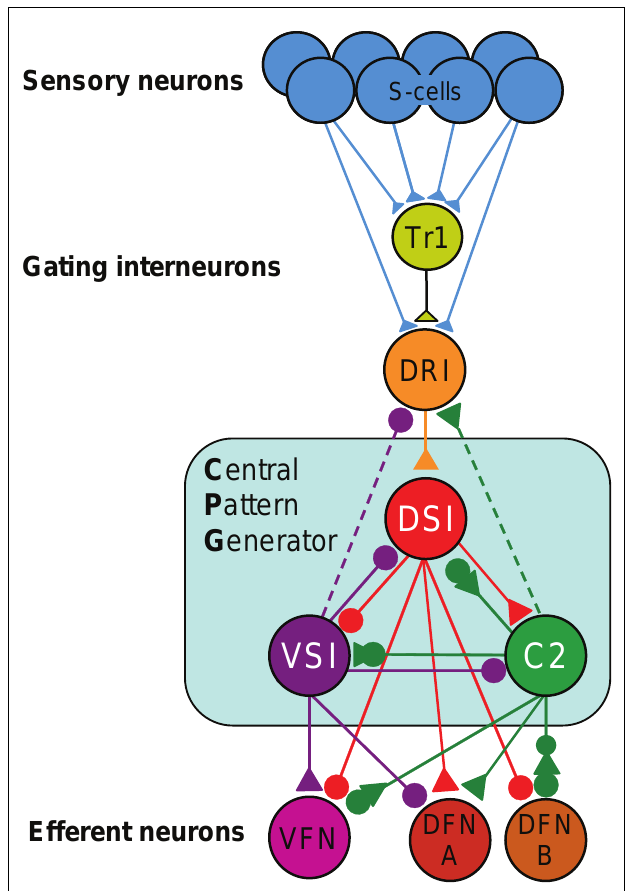
FIGURE 1 | Tritonia swim circuit. This image illustrates fundamental features of a neuronal wiring diagram used in publication. It represents neurons as balls and their synapses as sticks with triangles (excitatory), circles (inhibitory), or combinations of both. The names of the neurons are indicated on the